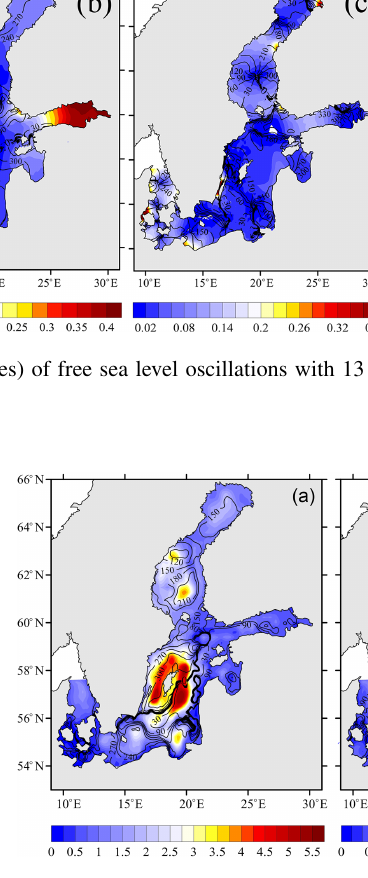
Figure 14. Amplitudes in cm (colour) and phases in degrees (co- tidal lines) of the free sea level oscillations in the baroclinic sea on periods of (a) 358d and (b)